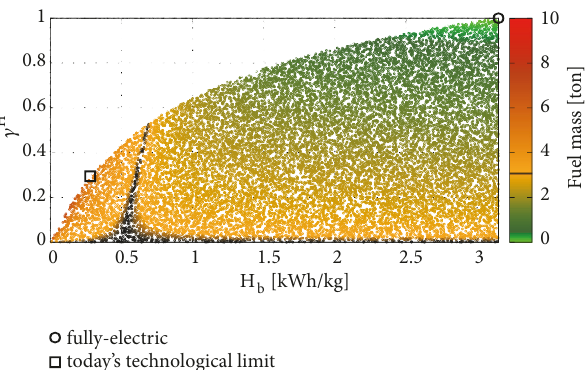
Figure 8: Parametric analysis of fuel mass consumption as function of degree of hybridisation and battery specific energy technology in comparison with iso-fuel solutions (black area) for the configuration characterised by mission requirements of a range of 100-pax and 900 nmi.